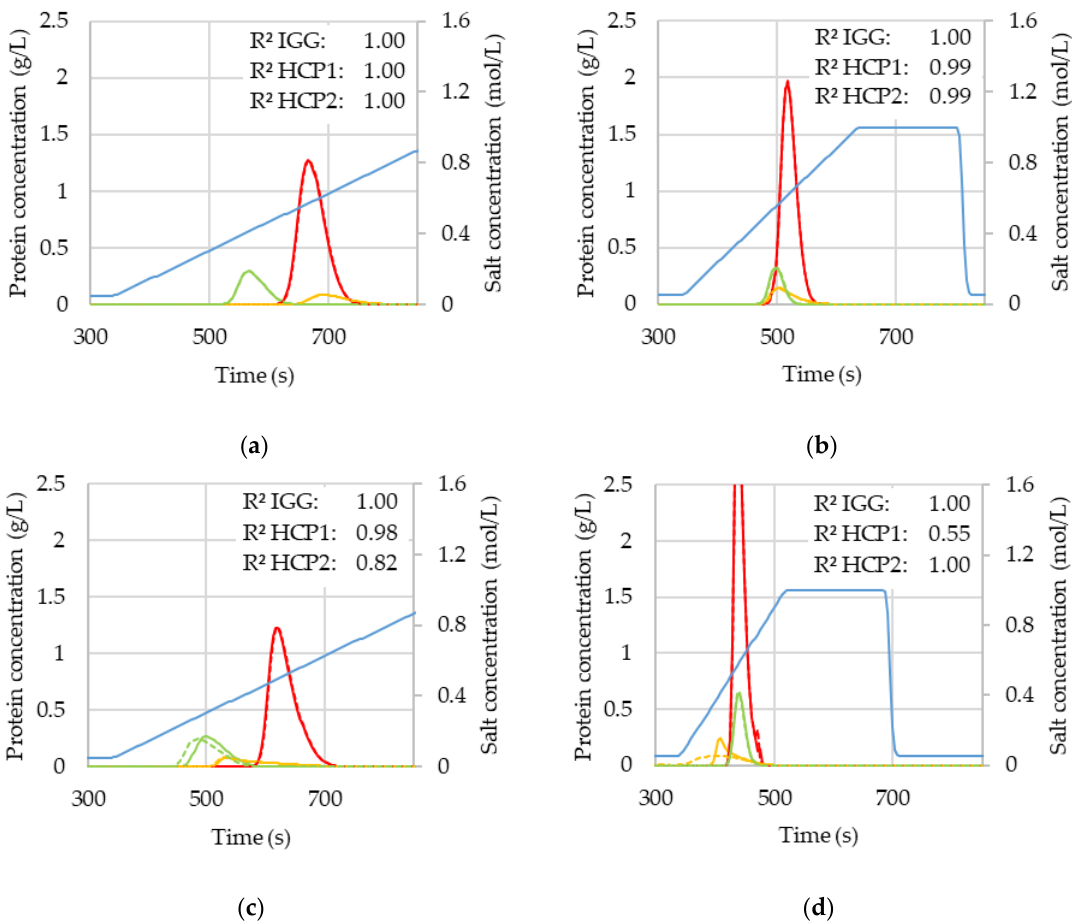
Figure 8. Comparison of four chromatograms with original and ANN predicted isotherm parameters from the validation set. In all subplots, the protein group HCP1 is yellow, the protein group HCP2 is green, and the IgG is red. Solid lines represent the chromatograms original isotherm parameters. Dashed lines represent the chromatograms with ANN predicted isotherm parameters: ( a ) depicts a chromatogram comparison at 10 CV, ( b ) is another comparison at 5 CV, ( c ) depicts one of the outliers at 10 CV, and ( d ) is the worst outlier at 3 CV.